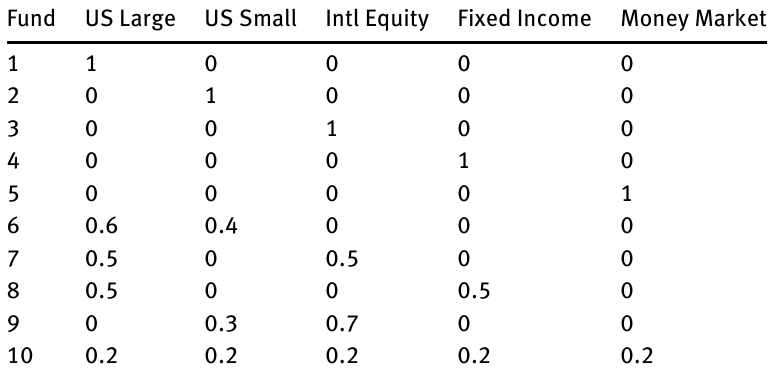
Table 2: Ten investment funds. Each row is a mapping from an investment fund to a combination of five indices.